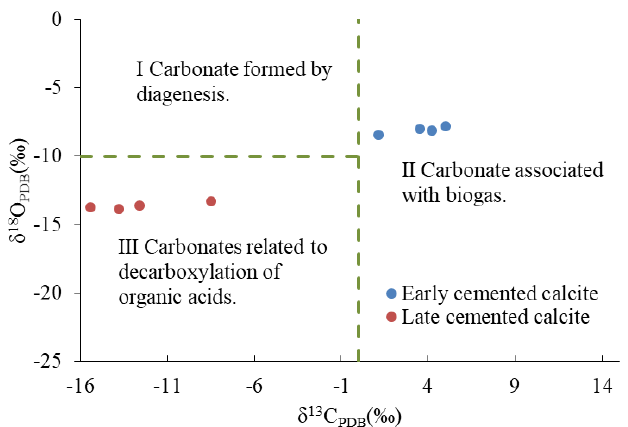
Figure 12. A scatter plot of δ 13 C PDB and δ 18 O PDB of calcite.